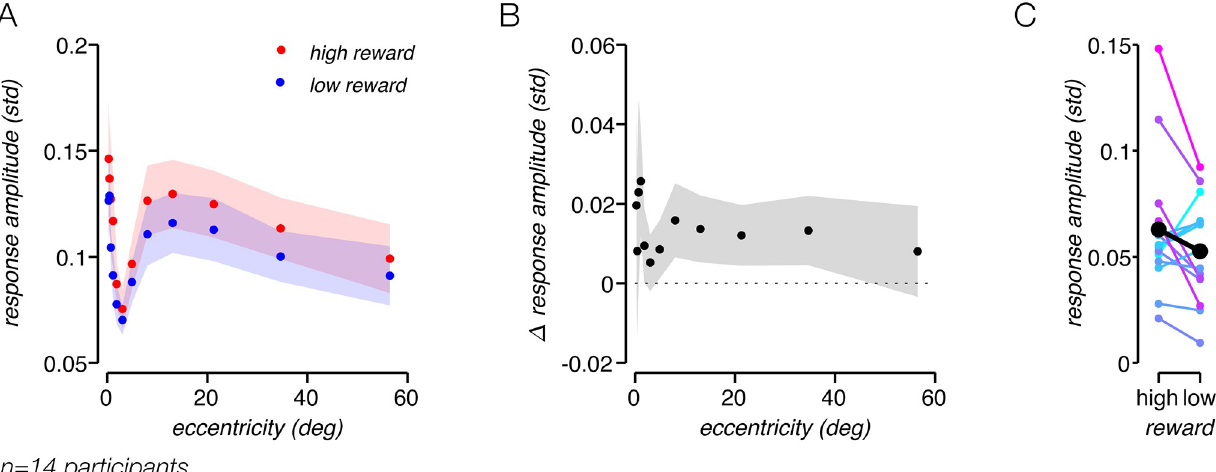
Fig 4. Task-related response amplitude is modulated by reward. (A) EVC task-related response amplitude as function of eccentricity. Shaded regions, ± SEM across participants. (B) Low-reward amplitude subtracted from high-reward amplitude as function of eccentricity. (C) Amplitude of EVC task- related response, for all participants. Amplitude was quantified by the std of the average trial. Data points and lines connecting high- and low-reward amplitudes are colored according to the difference between high- and low-reward amplitude for each participant. Underlying data can be found at https:// osf.io/cbjq6/. EVC, early visual cortex; fMRI, functional MRI; std, standard deviation.